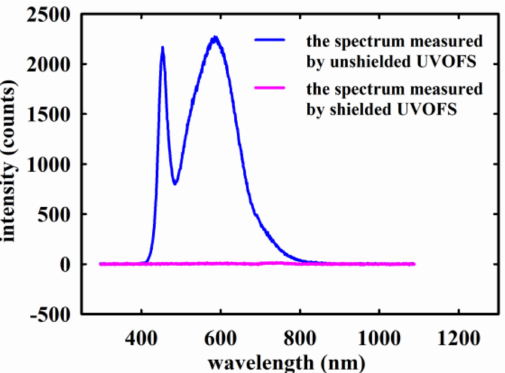
Figure 7. The experimental devices and method.